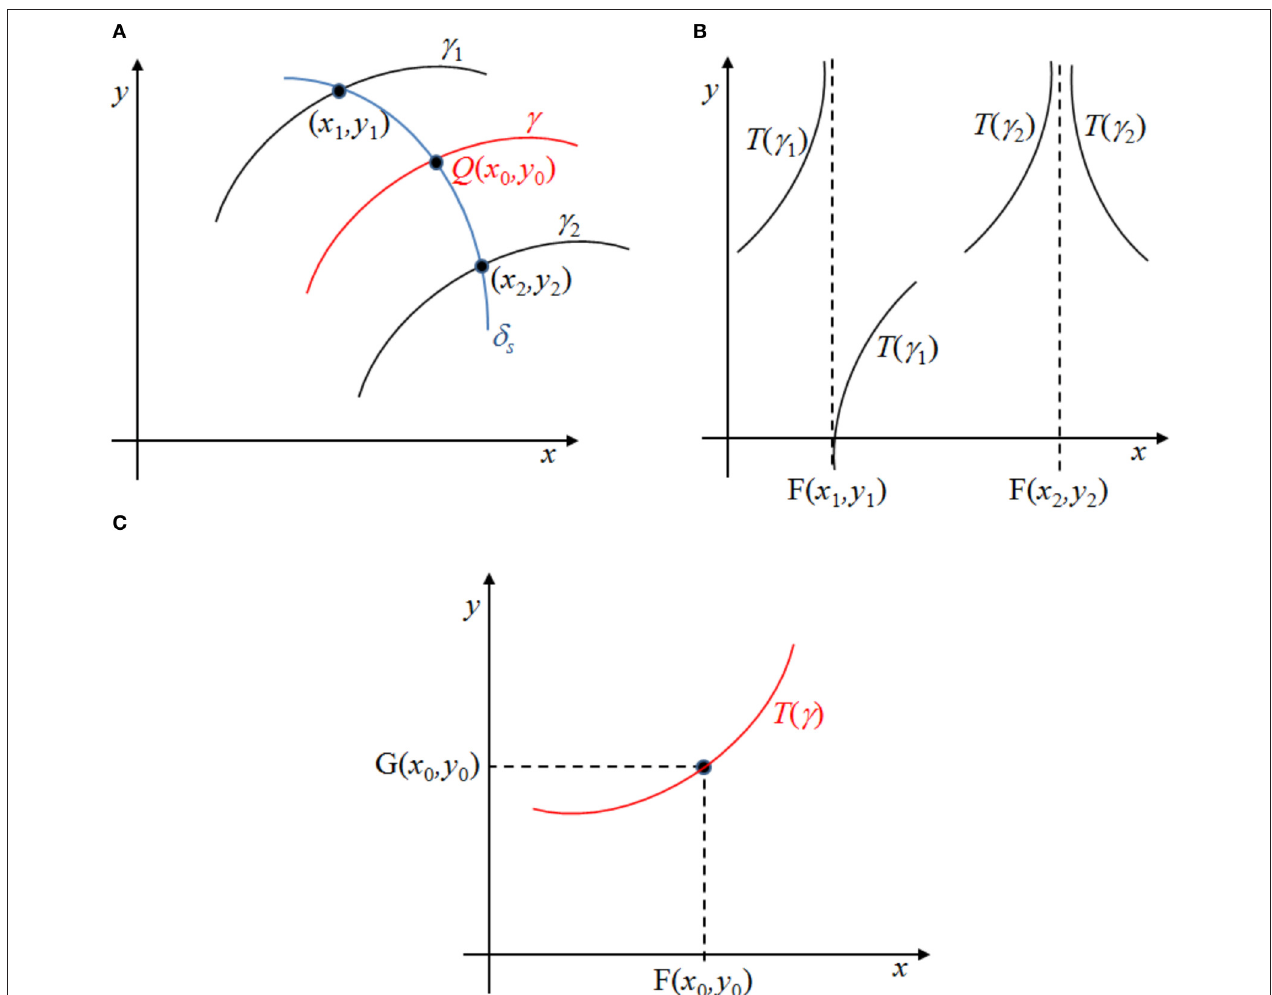
FIGURE 1 | The action of the map T on arcs transverse to the set of nondefinition (A) is different. If N ( x , y ) does not vanish when the denominator D ( x , y ) vanishes (or it does but the limit of the ratio is infinite) then the image of the arc is the union of two arcs separated by a vertical asymptote (B) . If both N ( x , y ) and D ( x , y ) vanish at the intersection and the limit of the ratio is finite, then the image is a continuous arc (C)